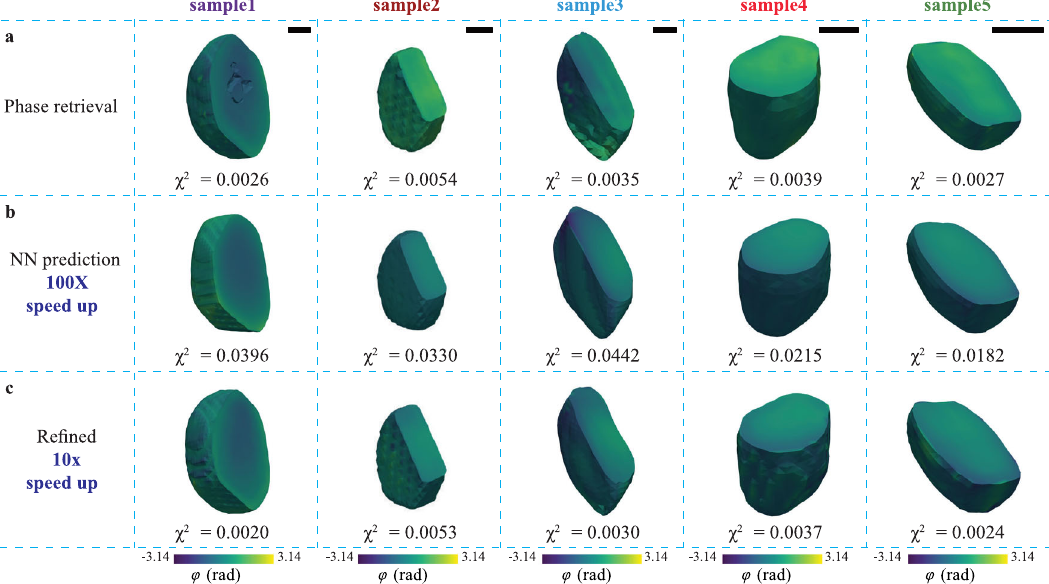
Fig. 3 Performance of AutoPhaseNN on real data from BCDI experiments. Comparison among reconstructions from a traditional phase retrieval, b prediction of the AutoPhaseNN model, and c re fi nement process. The crystals are clipped to show the internal strain fi elds and the images show the 0.3 contour of the amplitude and the color represents the phase. Reciprocal χ 2 errors are shown in the fi gures. The scale bars are all 150